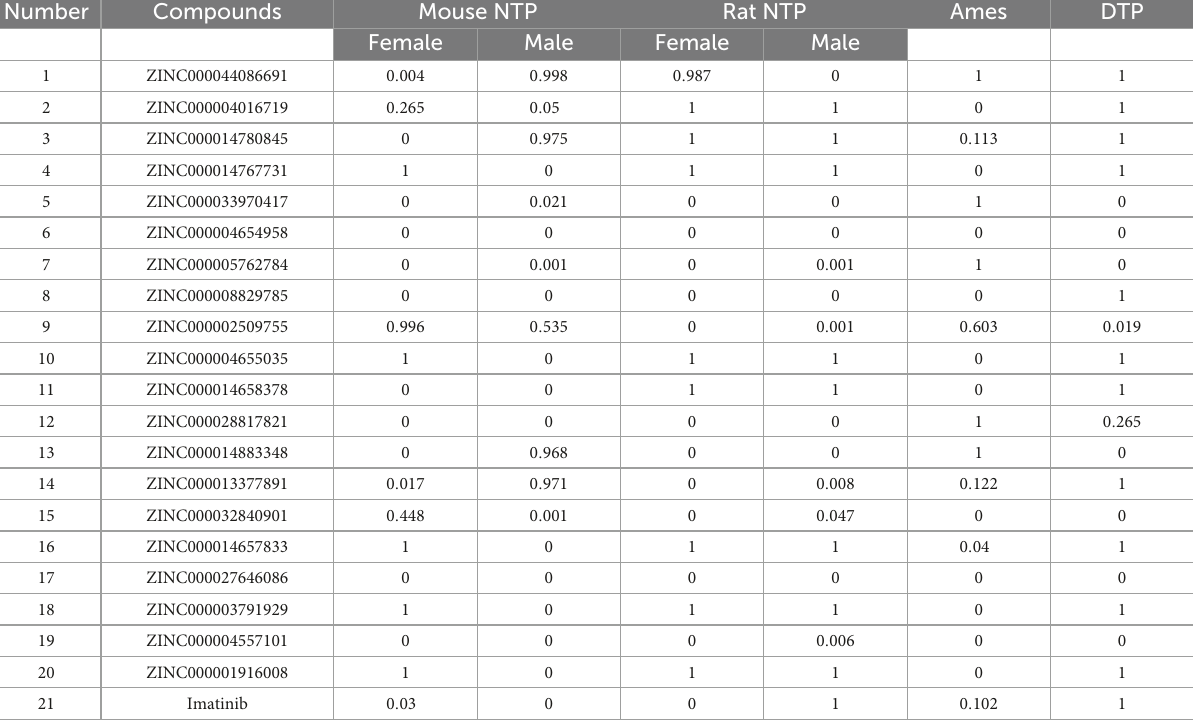
TABLE 3 Toxicities of